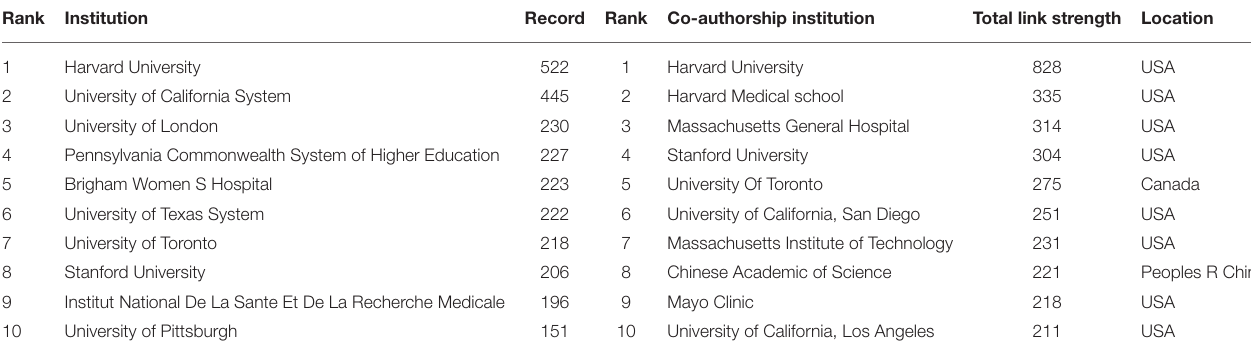
TABLE 2 | The top 10 institutions with the largest number of articles or the largest cooperation intensity. Rank